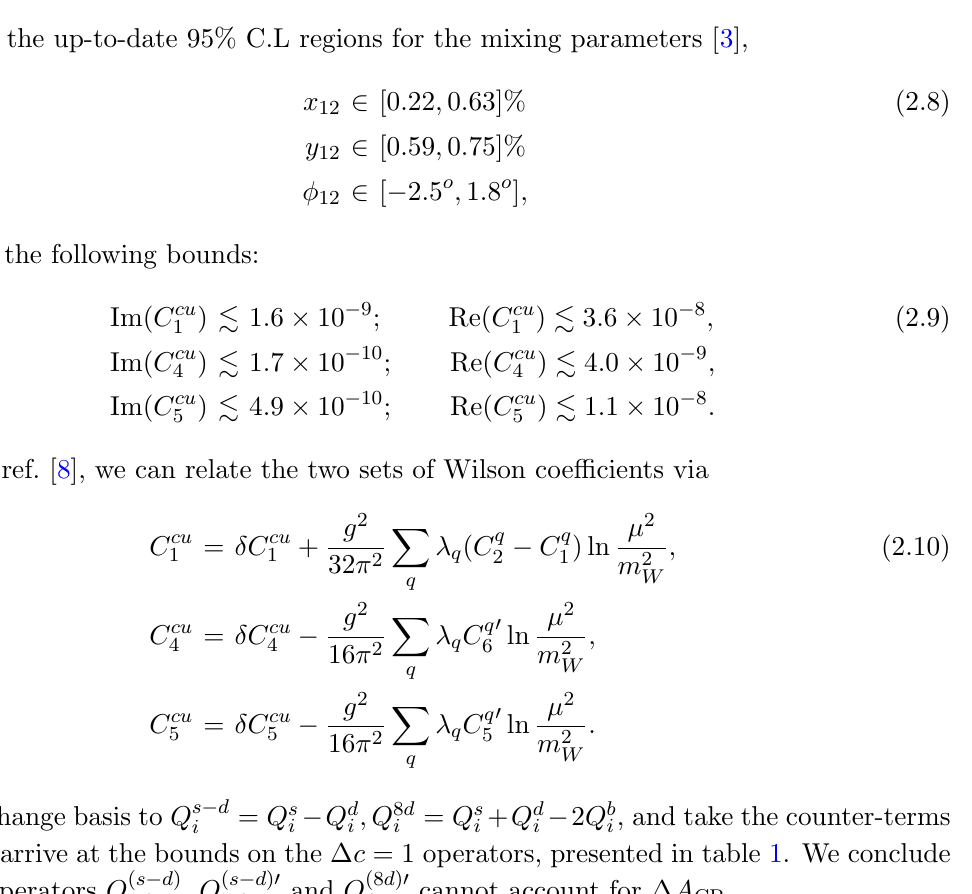
Table 1 . Upper bounds on CP violating (cid:1) c = 1 operators from D 0 (cid:0) D 0 mixing, at the hadronic charm scale (cid:22) (cid:25) 2